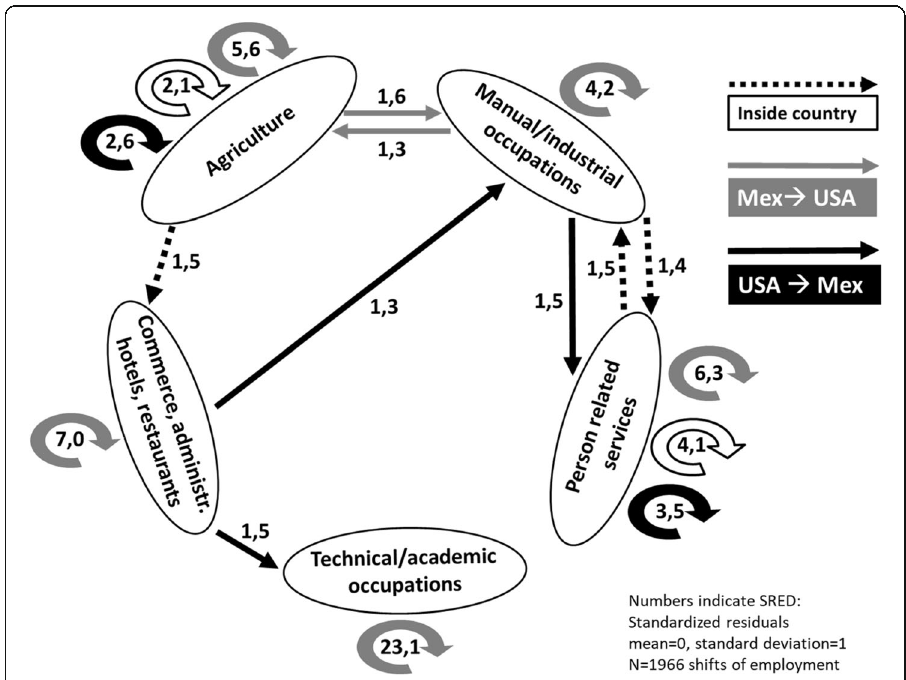
Fig. 4 Employment shifts according to change of country and